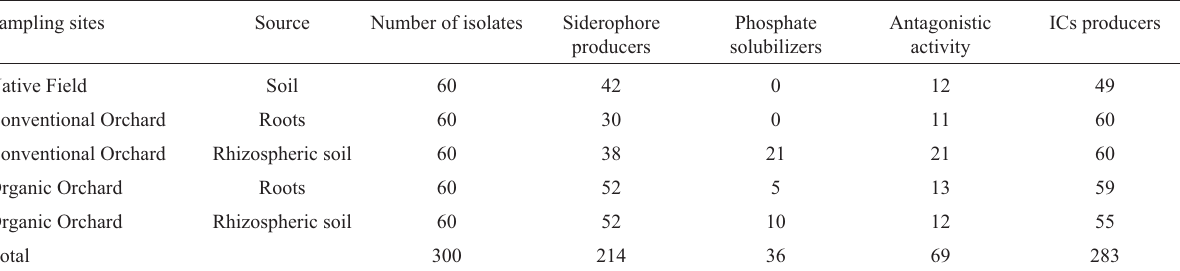
Table 2 - Ocurrence of siderophore and indolic compound (ICs) production, phosphate solubilization, and antagonistic activity of bacterial isolates by sampling site and niche.